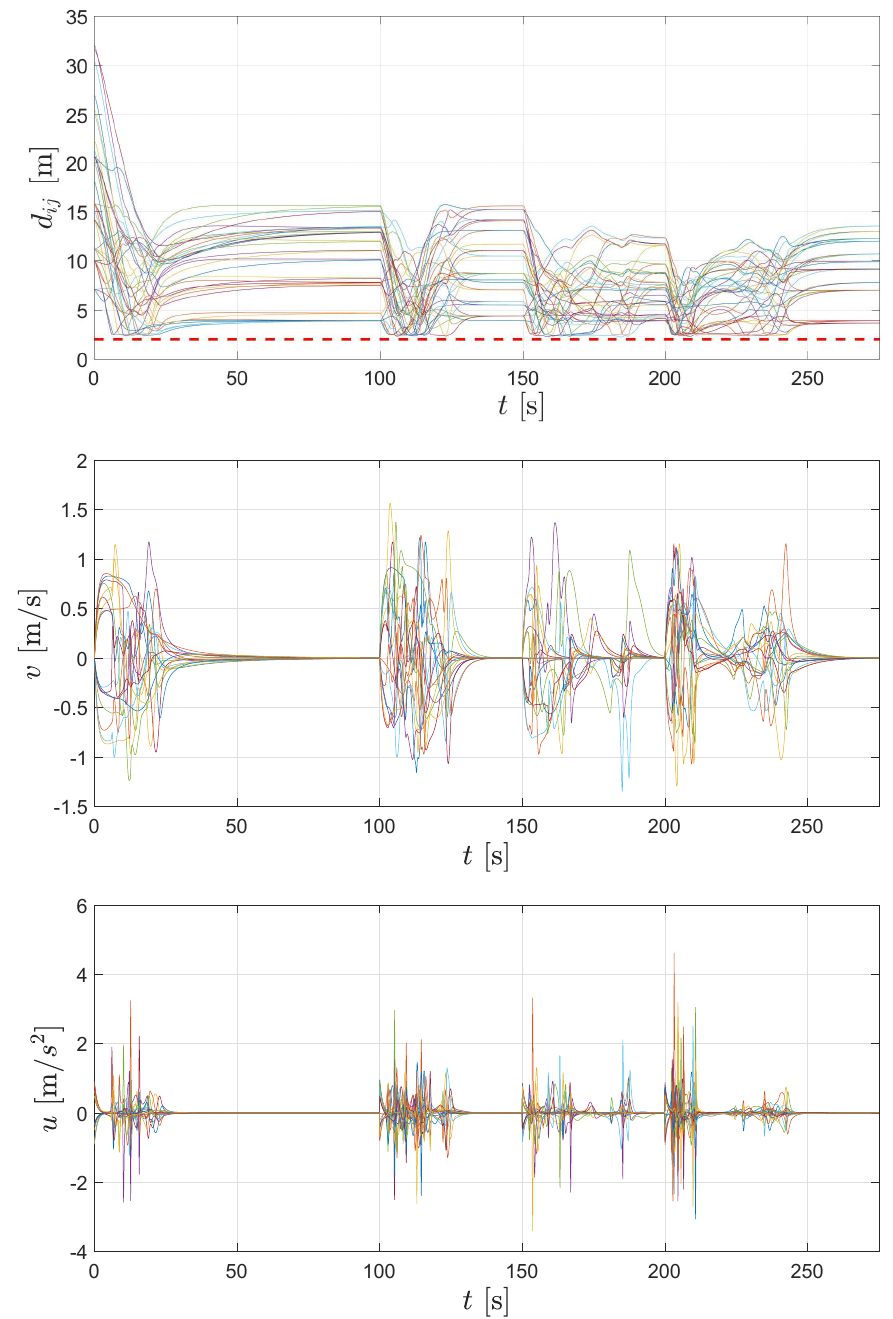
Figure 10. Distancesbetween an pair of agents, velocities and control inputs for whole